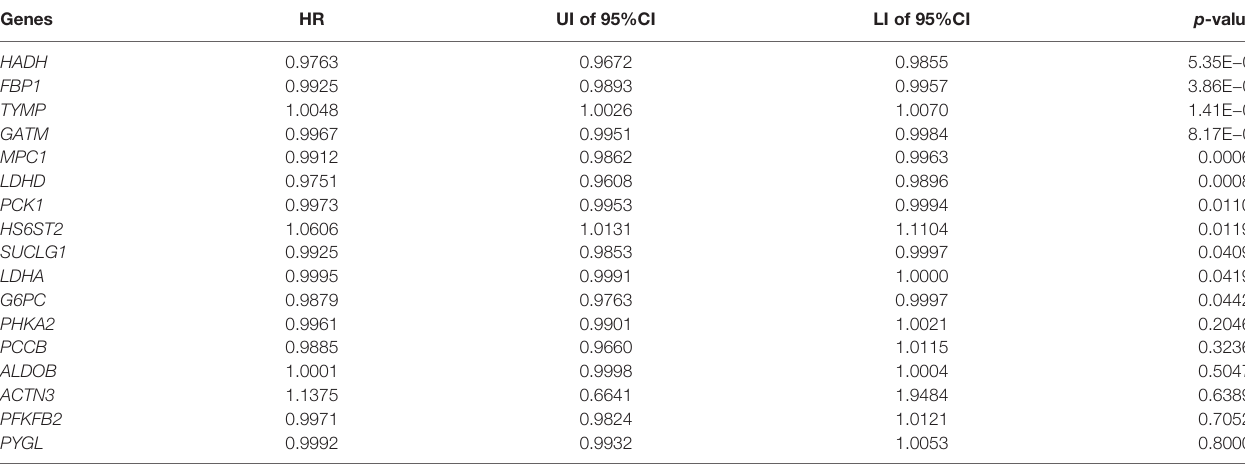
TABLE 2 | Univariate Cox regression analysis of the 17 differentially expressed lactate-related genes. Genes HR UI of 95%CI LI of 95%CI p -value HADH 0.9763 FBP1